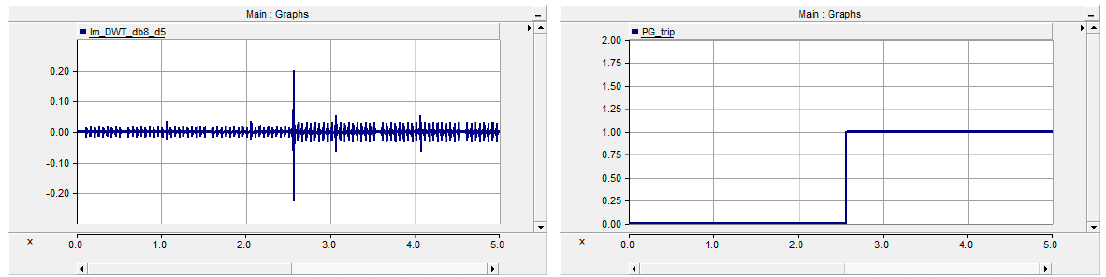
Figure 9. The simulation result under pole to ground (PtoG).